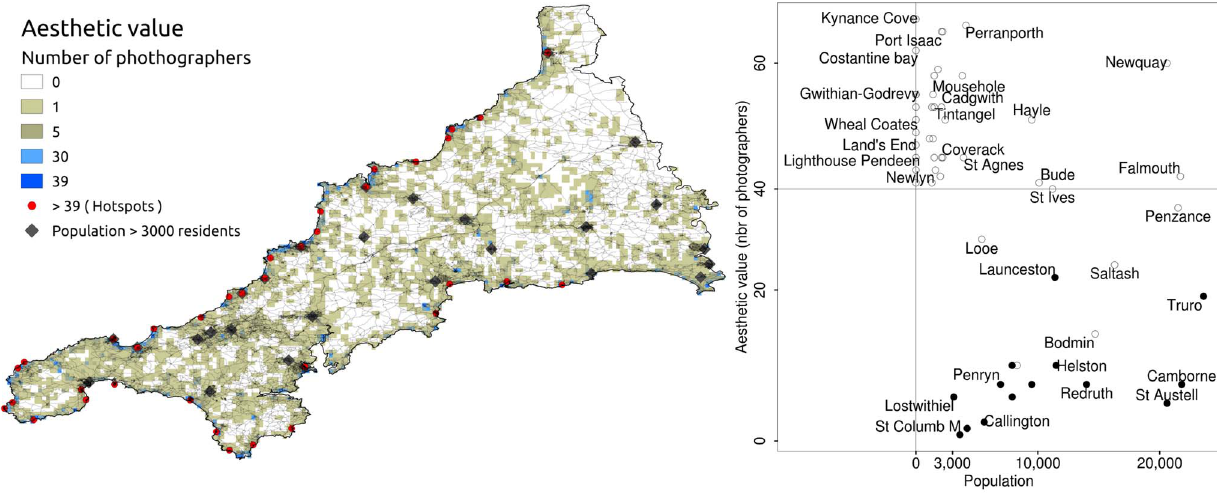
Figure 2. Aesthetic value and population of Cornwall. Aesthetic value map of Cornwall (left) and spatial covariance with the most populated places in Cornwall (right). Population data: Office for National Statistics, mid year estimates 2010. White dots: coastal locations; black dots: inland locations (not all location labels are shown).